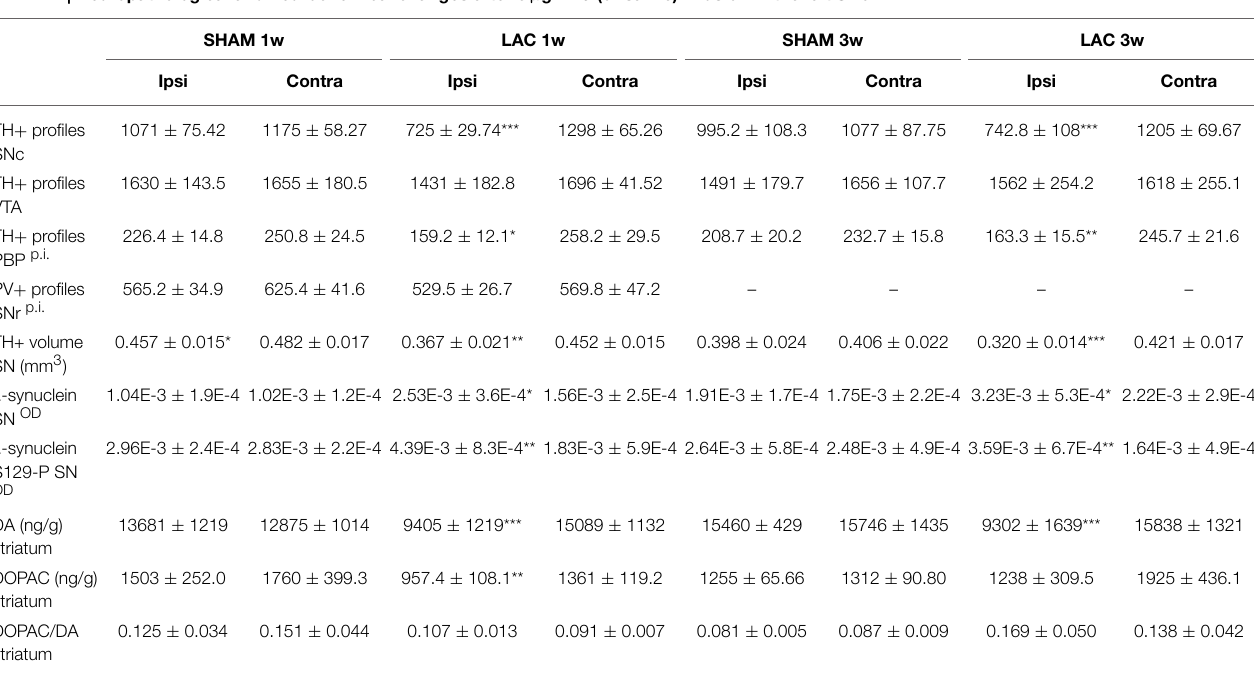
TABLE 1 | Neuropathological and neurochemical changes after 3 µ g LAC (or saline) infusion in the left SNc. SHAM 1w LAC 1w SHAM 3w LAC 3w Contra Ipsi Contra Ipsi Contra Ipsi